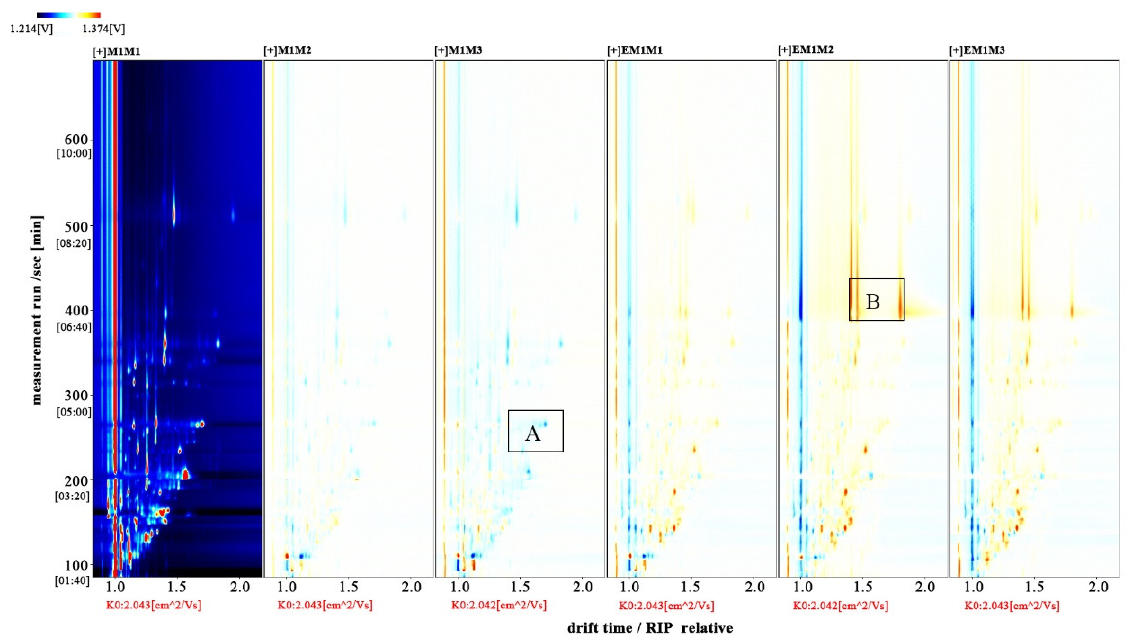
Figure 4. Difference diagram of gas-phase ion mobility spectra of Micropterus salmoides muscles. Note: M1M1, M1M2, and M1M3: three samples from the M group. EM1M1, EM1M2, and EM1M3: three samples from the EM group.